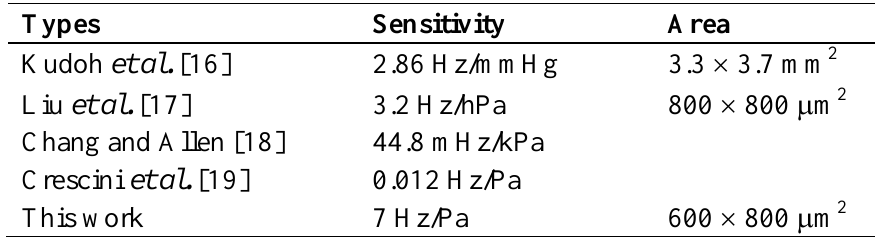
Table 1. The sensitivity and area in many micro pressure